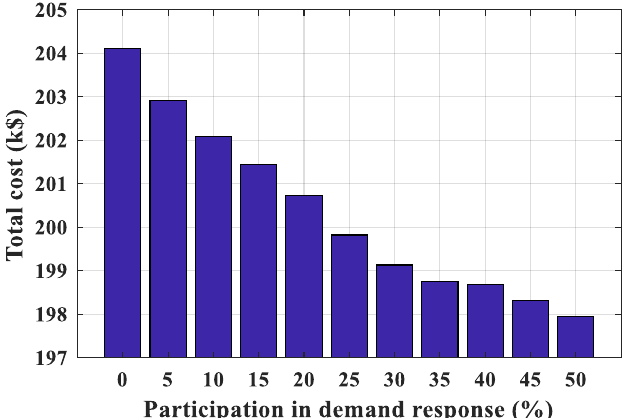
Figure 14. Decreasing trend of the total cost of the system for a typical day in the week 51 respects to demand response. Table 13. Generation units’ data of the second system. Table 12. The units’ cost for different participation percent in demand response for a typical day in week 51. Power-only